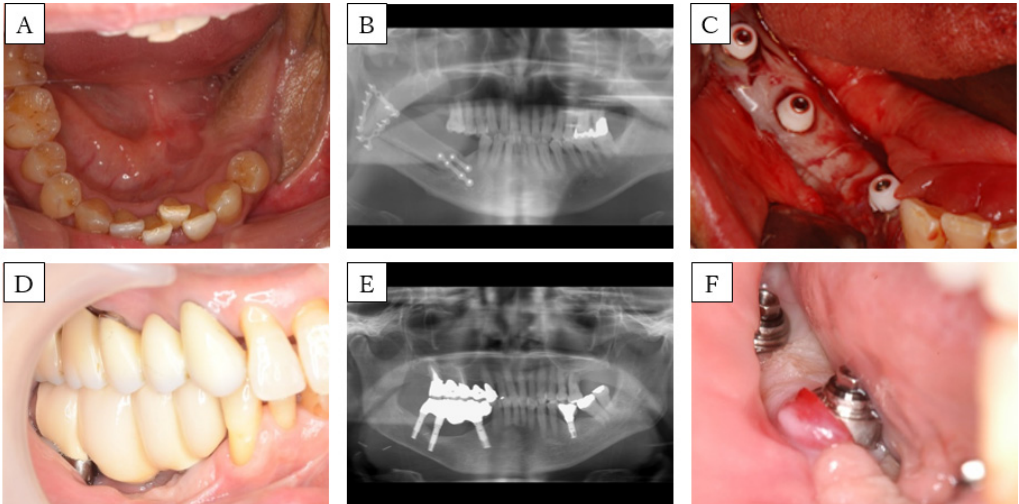
Figure 3. Case 2. ( A ) Preoperative intra-oral picture of the mandibular reconstructions with fibula- free flaps. ( B ) panoramic radiograph of the patient before implant placement. A single-barrel fibula was placed corresponding to the mandible. ( C ) Postoperative intra-oral picture of the FGG. ( D ) Intra-oral picture and ( E ) panoramic radiograph of the patient after setting the prosthesis. ( F ) Intra-oral picture during follow up. Peri-implant mucosa is reddish and swollen.